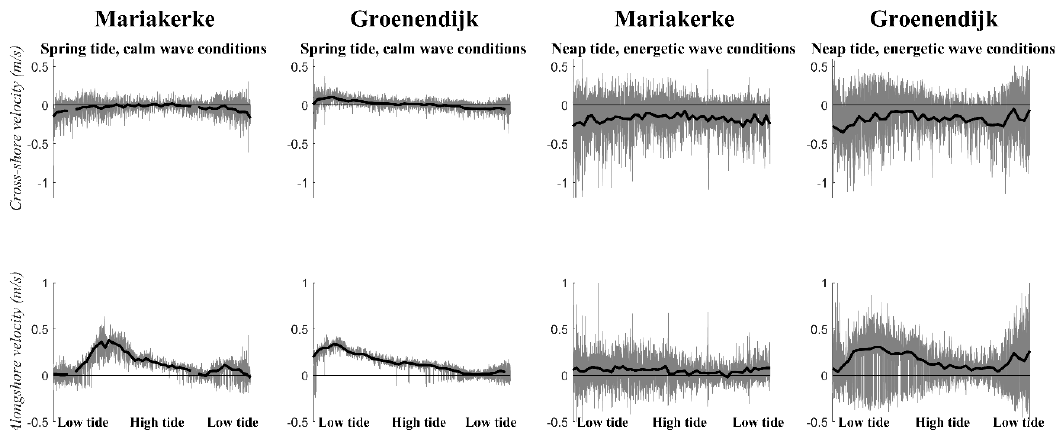
Figure 5. Cross-shore ( top ) and alongshore ( bottom ) flow velocity at 35 cm above the bed over one tidal cycle during spring tide and calm wave conditions ( left ) vs. neap tide and strong waves ( right ), with the measured flow velocity in grey and the 10-minute averaged flow velocity in black.